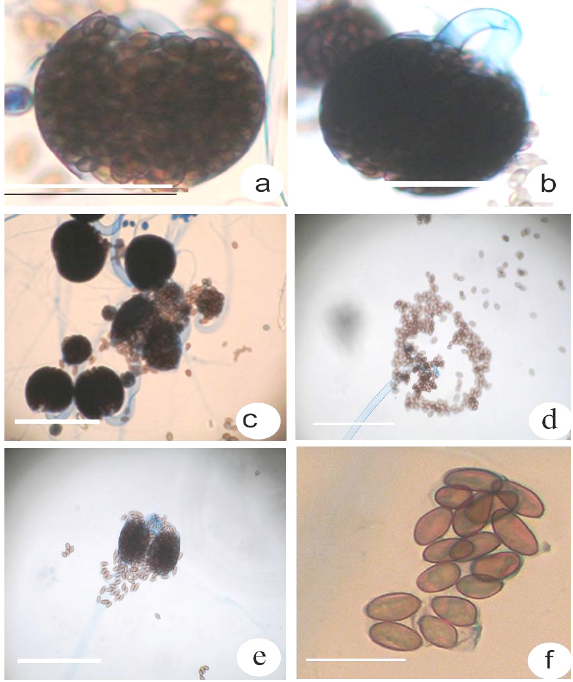
Image 1. Abradeosporangium variosporum gen. et sp. nov. a, b – Mature macrosporangia with goose-necked sporangiophores; c – Macro- and microsporangia; d – Distal part of sporangiophore after dehiscence of the macro- sporangium, without columella; e – Macrosporangium dehisced along the longitudinal suture;